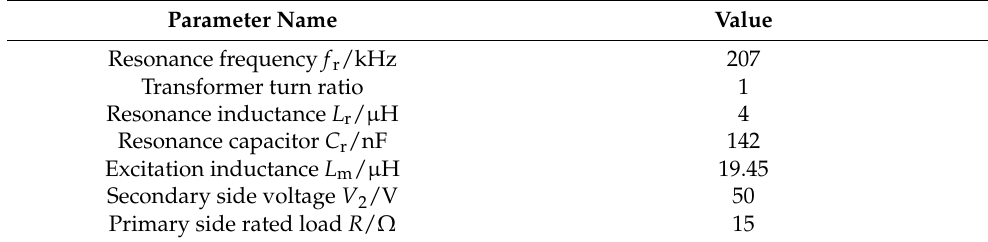
Table 3. The design parameters of the prototype.